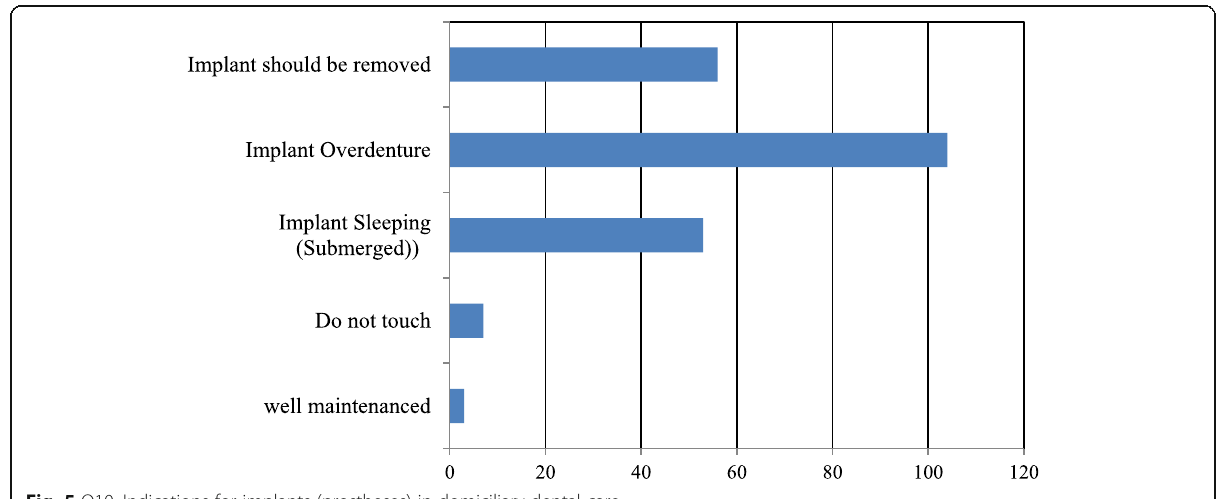
Fig. 5 Q10. Indications for implants (prostheses) in domiciliary dental